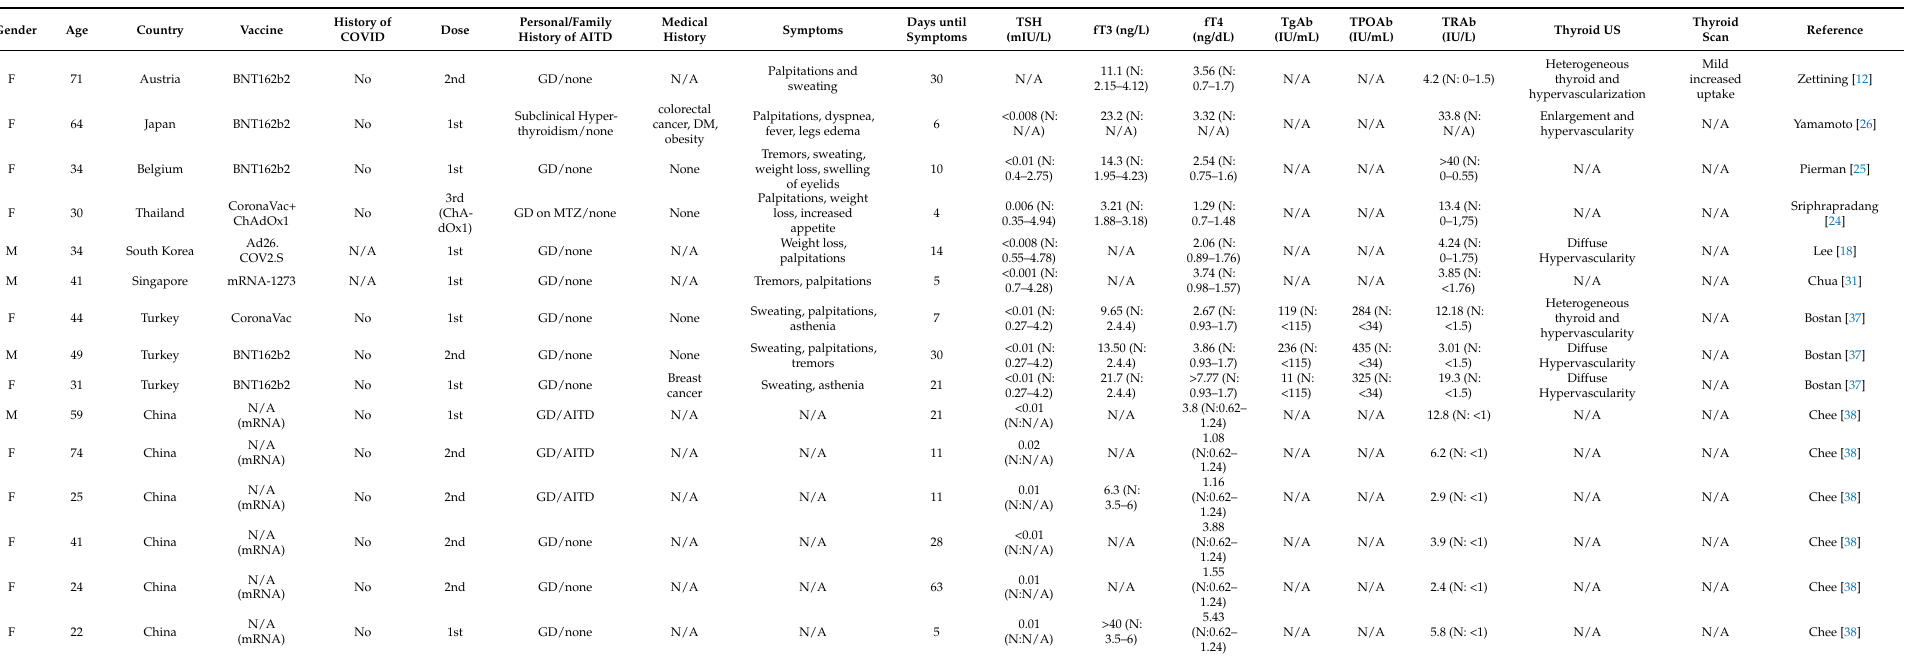
Table 2. Summary of demographic, clinical, and laboratory characteristics of Graves’s disease relapses following SARS-CoV-2 vaccination in the